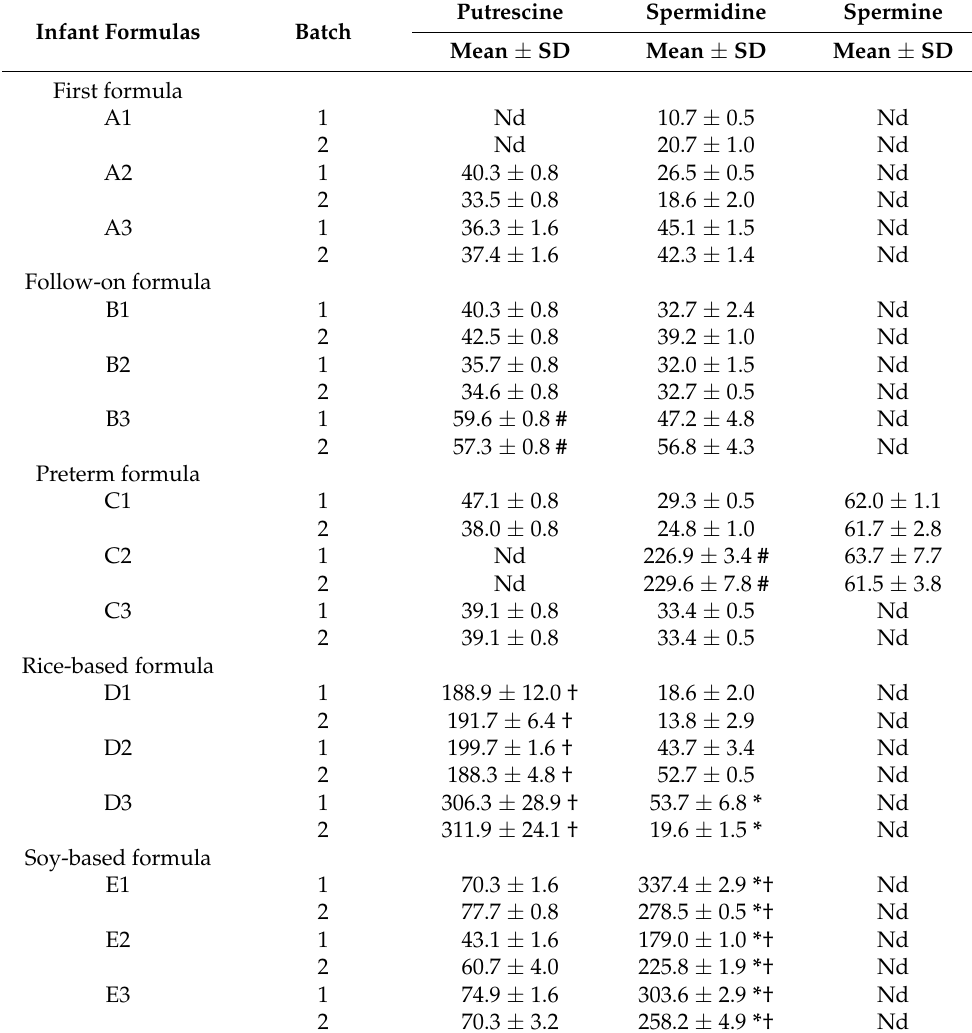
Table 1. Polyamine content (nmol/dL) in different types of infant formulas. Infant